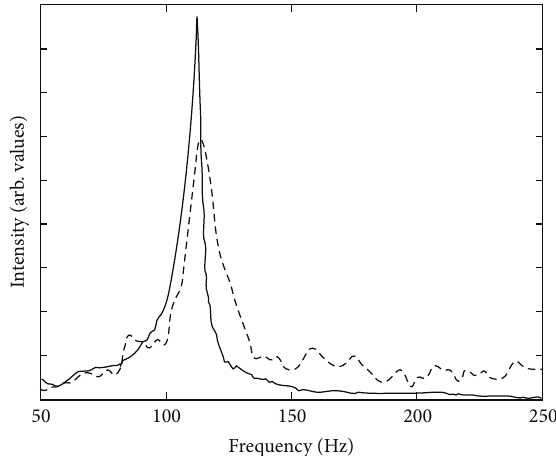
Figure 7: Response of a Helmholtz resonator with a ping pong ball below the neck (solid line) and the empty Helmholtz resonator (dashed